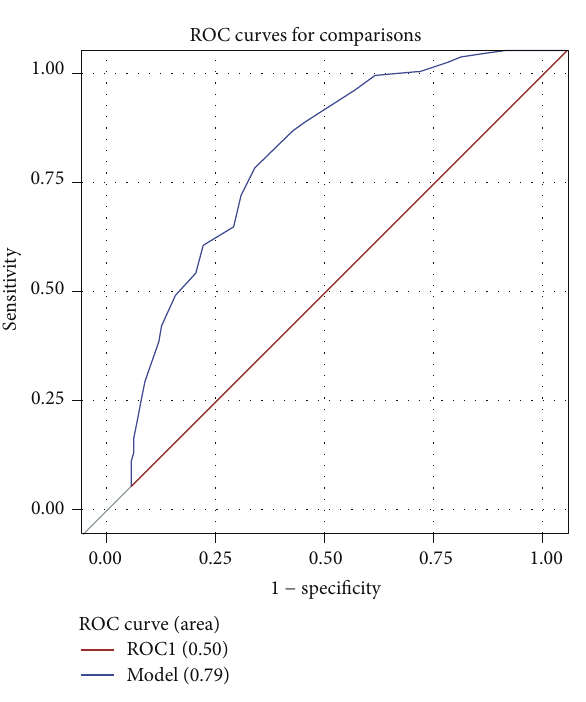
Figure 2: ROC curve for LIPS predicting ARDS. The area under the curve is 0.79, demonstrating LIPS is a strong predictor of the development of ARDS. Additionally, by maximizing the sensitivity and specificity, a LIPS value of 7 was determined to be statistically significant for deciding when a patient will be at high risk for developing